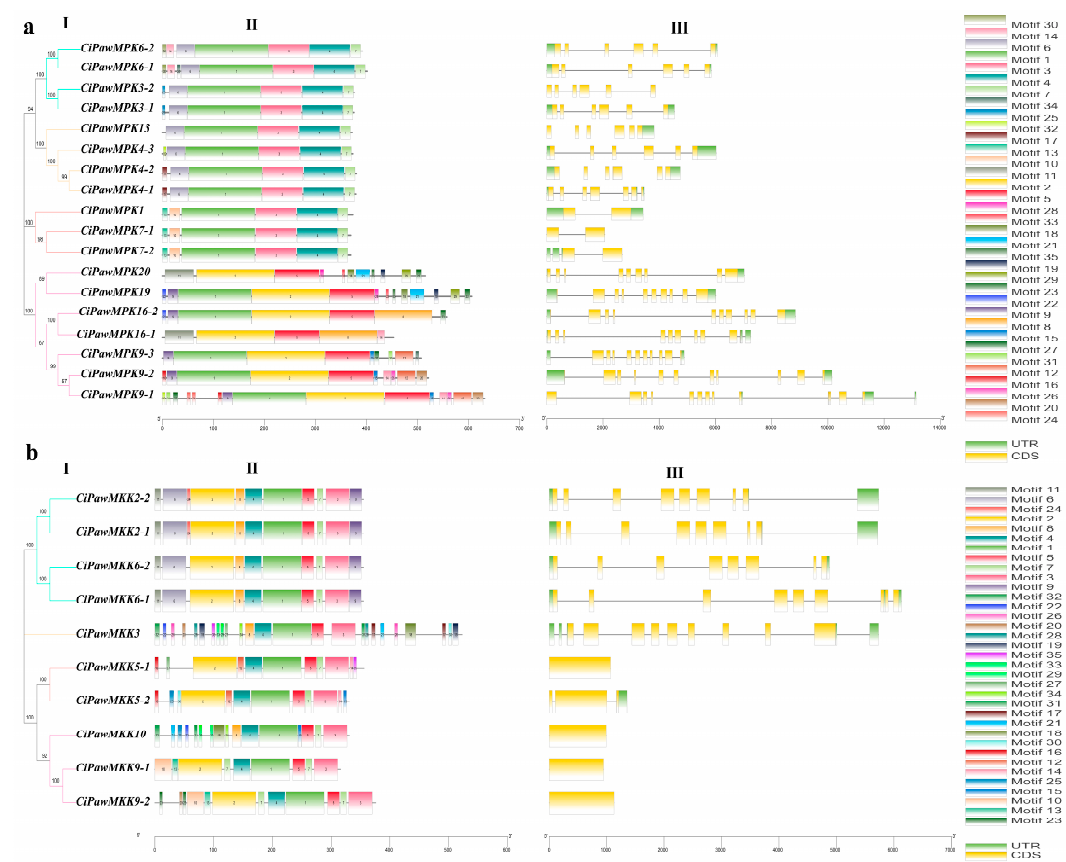
Figure 3. Evolutionary tree ( I ) , motifs ( II ) , and gene structure ( III ) analysis of MPK ( a ) and MKK ( b ) in pecan.